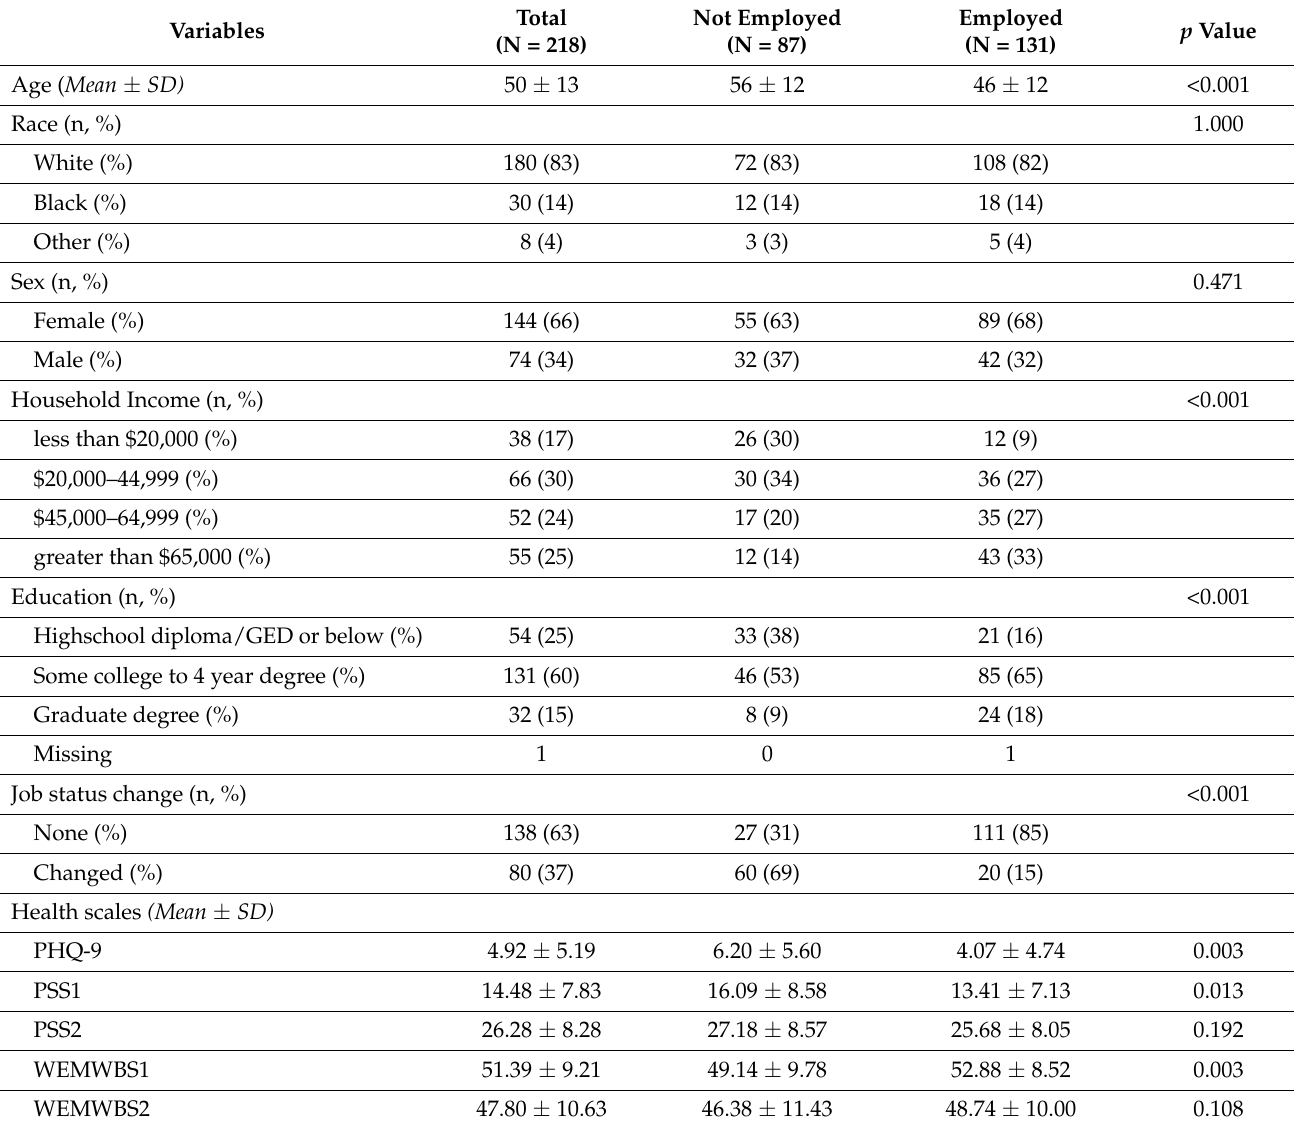
Table 1. Characteristics of study participants by employment